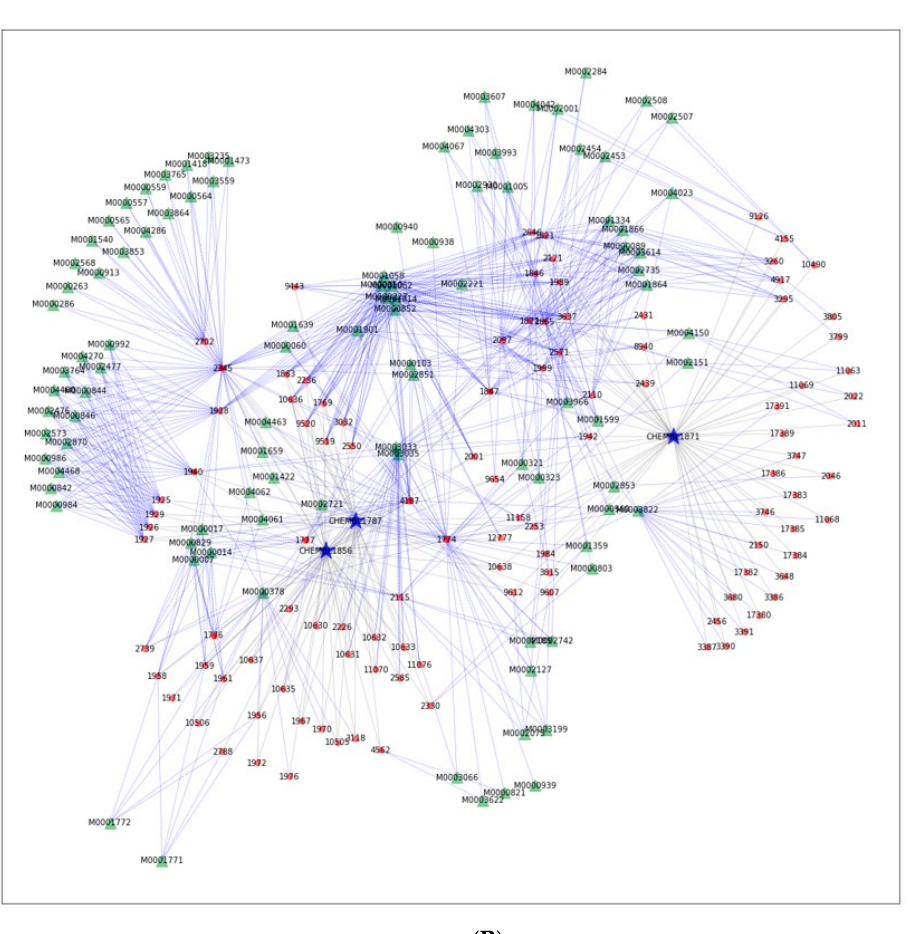
Figure 4. ( A ) The network diagram for the plants cluster having the largest TPS index to the target ”Tyrosinase” (CHEMBL3318). ( B ) The combined network generated from three network diagrams for the plants cluster having the largest TPS index to the three targets, ”steroid 5 α -reductase 1“ (S5R1, ChEMBL1787), ”steroid 5 α -reductase 2“ (S5R2, ChEMBL1856) and ”androgen receptor” (AR, ChEMBL1871). The chemical profiles sharing from chemicals from S5R1 and S5R2, from S5R1 and AR and from S5R2 and AR. Table 2. List of chemicals simultaneously acting on three targets, S5R1, S5R2 and AR.